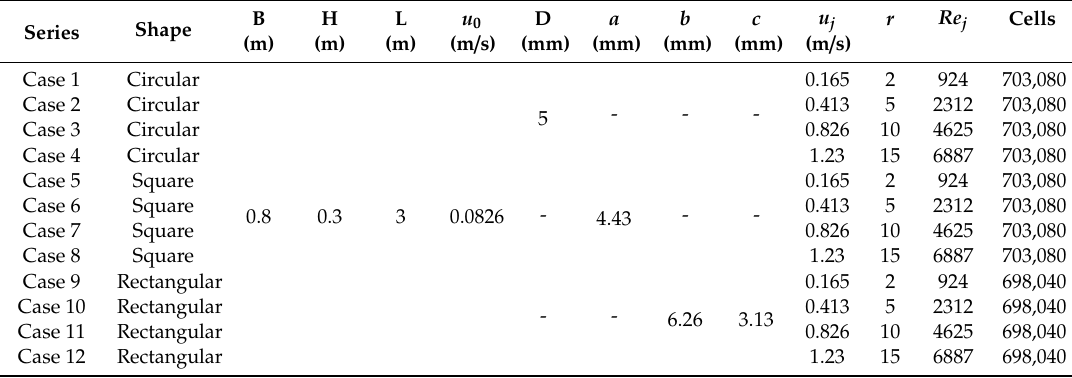
Figure 1. Three-dimensional (3D) view of the model layout. Table 1. Parameters of different cases.